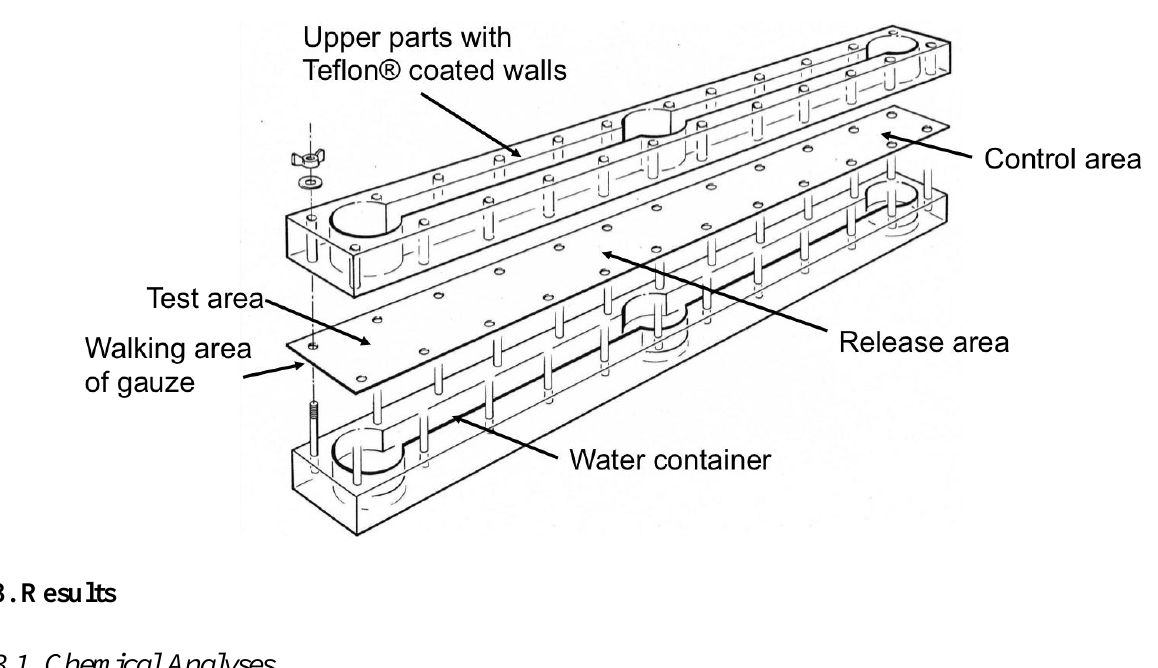
Figure 3. Long range olfactometer used to test the attraction for house dust mites D. pteronyssinus of chemical substances over larger